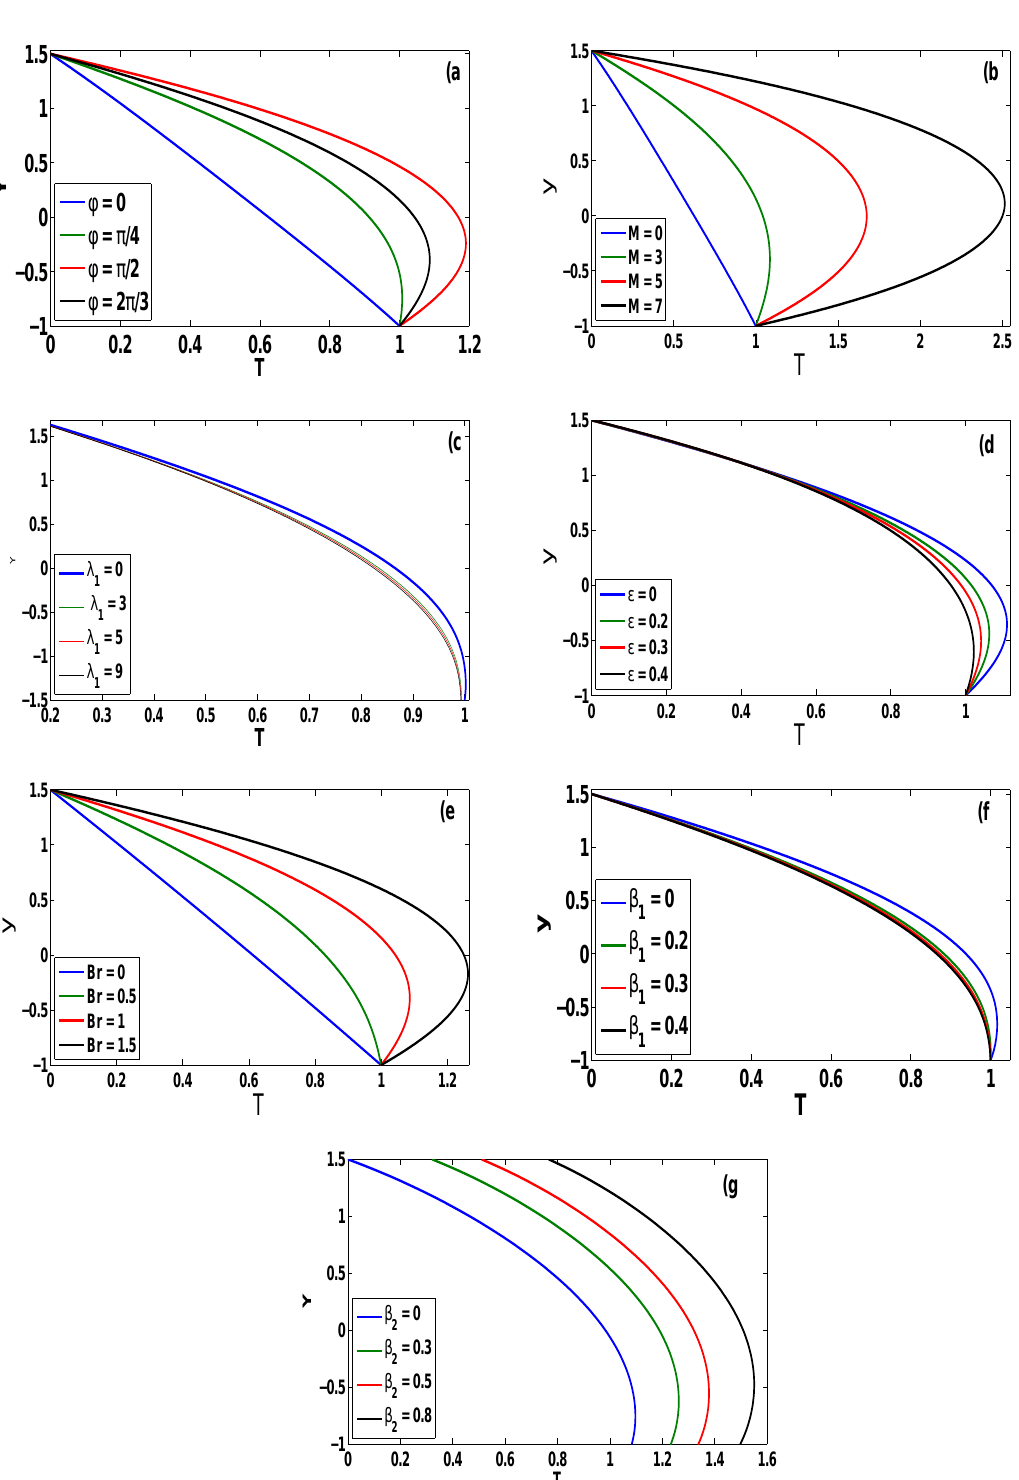
Figure 5. Distribution of temperature( T ) vs y for x = 0, Q = − 1.2, ( a ) : ε = 0.1, M = 4, λ 1 = 1, β 1 = 0.2, β 2 = 0.2 Br = 1, ( b ) : ε = 0.1, ϕ = π /4, β 1 = 0.2, β 2 = 0.2, λ 1 = Br = 1, ( c ) : ϕ = π /4, M = 4, Br = 1.5, β 1 = 0.2, β 2 = 0.2, ε = 0.1, ( d ) : ϕ = π /4, M = 4, Br = 1, β 1 = 0.2, β 2 = 0.2, ( e ) : ε = 0.1, ϕ = π /3, β 1 = 0.2, β 2 = 0.2, M = 4, λ 1 = 1, ( f ) : ε = 0.1, ϕ = π /4, λ 1 = Br =